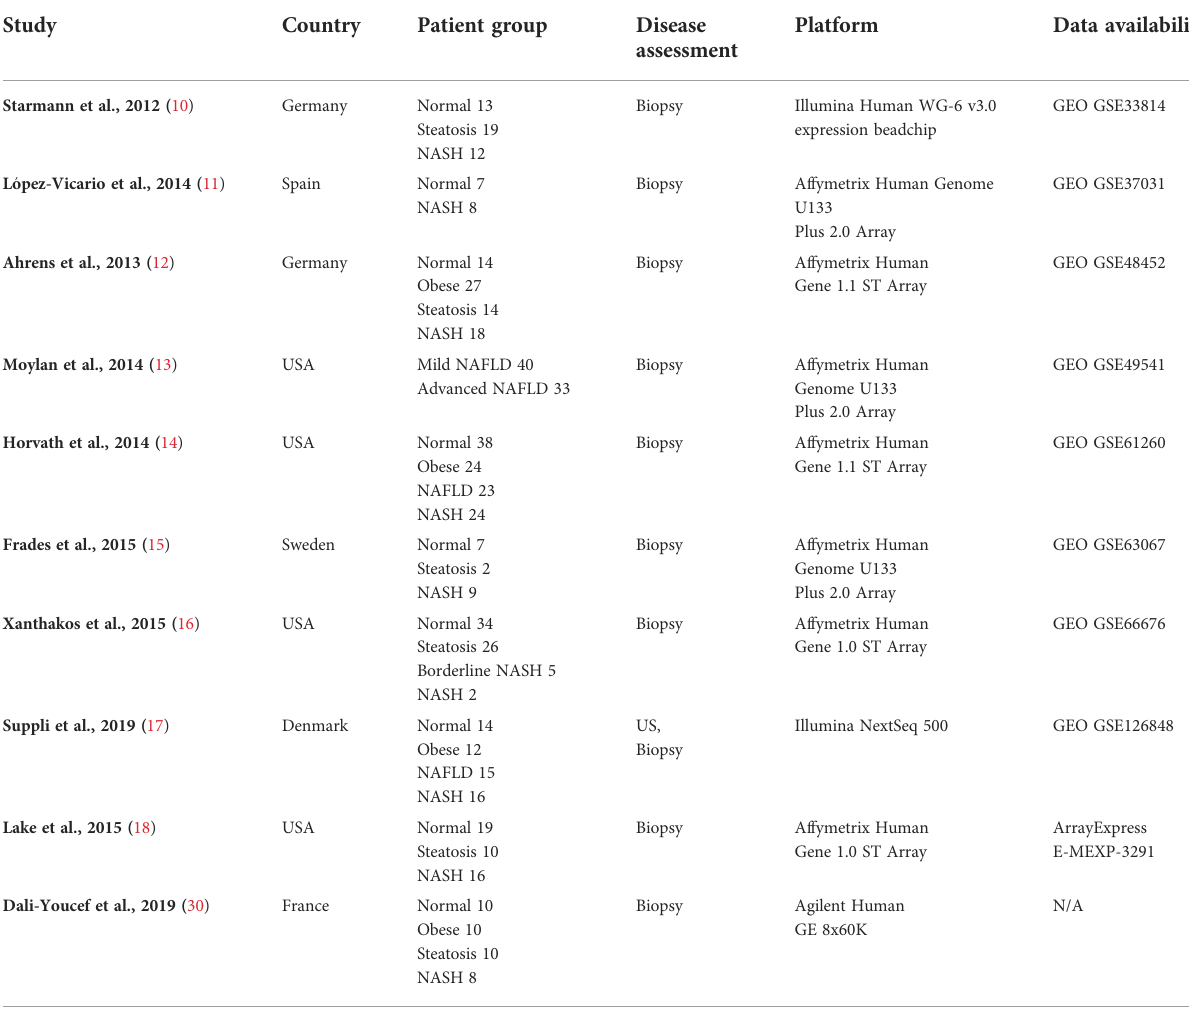
TABLE 1 Study characteristics of human NASH transcriptome datasets used in this